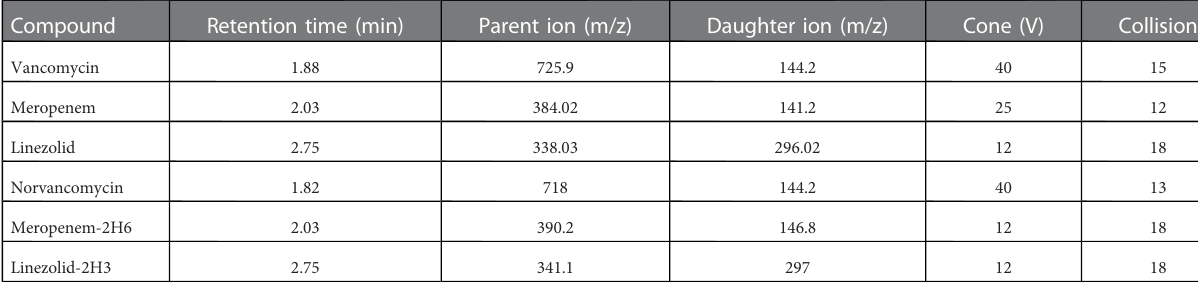
TABLE 1 Retention time, MRM transitions and compound-speci fi c MS settings.